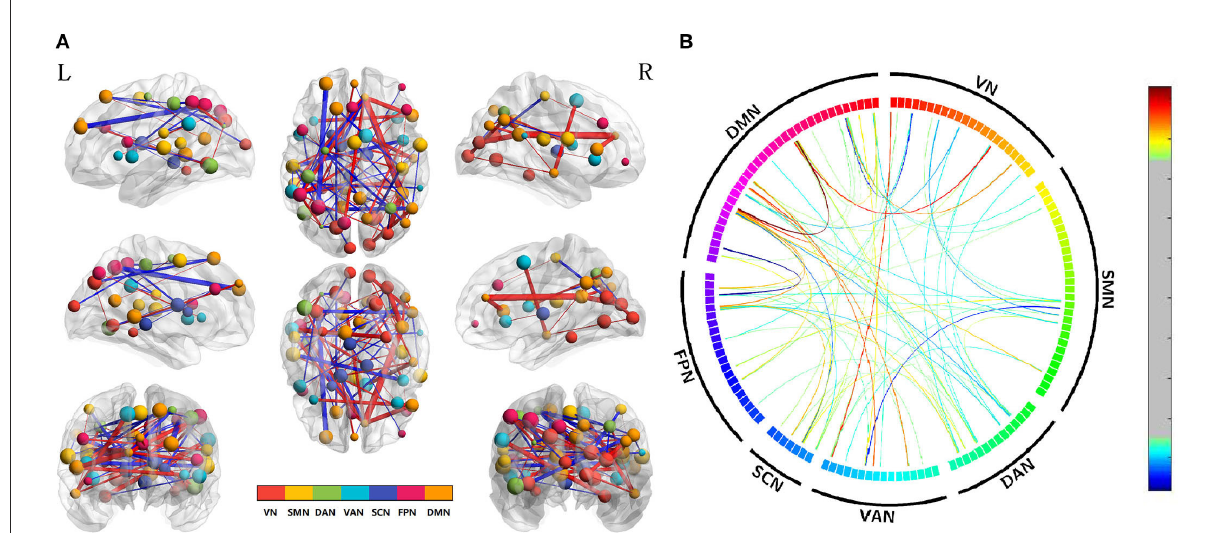
FIGURE2 Altered edge-based functional connectivity between the acute SD and RW states. (A) The brain maps show the affected edges (lines) and their connecting nodes (spheres) from several perspectives. The size of a node indicates how many affected edges are connected to this sphere. Bigger nodes have more affected edges than smaller ones. The color of a node indicates which network it belongs to. The warm color of edges indicates the increased FC after acute SD, while the cold color of edges indicates the decreased FC. (B) ROI to ROI connectivity of seven networks in panels. The result was corrected by NBS ( p < 0.01, two-tailed, permutation with 5,000 iterations). DAN, dorsal attention network; DMN, default mode network; FC, functional connectivity; FPN, frontoparietal network; L, left; R, right; SCN, subcortical network; SMN, somatosensory network; VAN, ventral attention network; VN, visual network; RW, rested wakefulness; SD, sleep